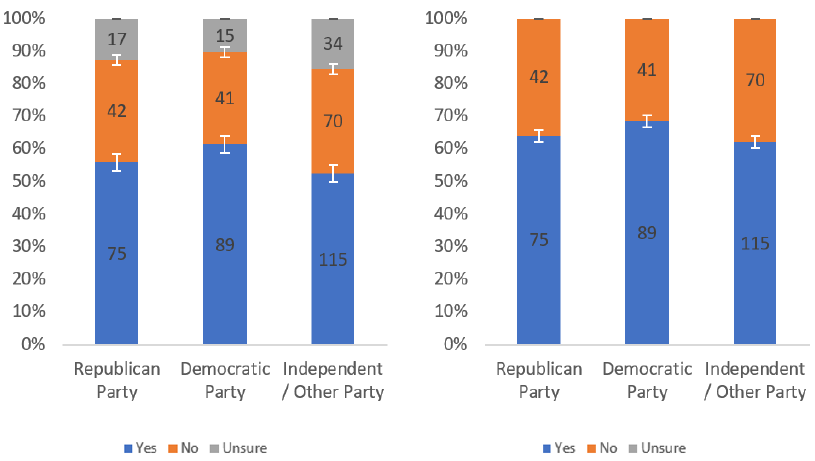
Figure 46. Responses regarding respondents’ willingness to review by party affiliation including ( left ) and excluding ( right ) unsure responses.